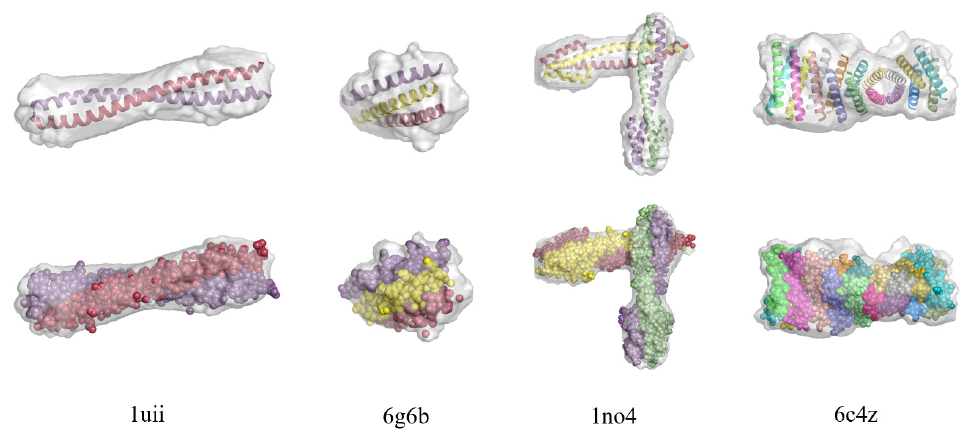
Figure 10. The reconstructed molecular envelopes of 1uii, 6g6b, 1no4 and 6c4z. The PDB posted model is shown as cartoon in the first row and as sphere in the second